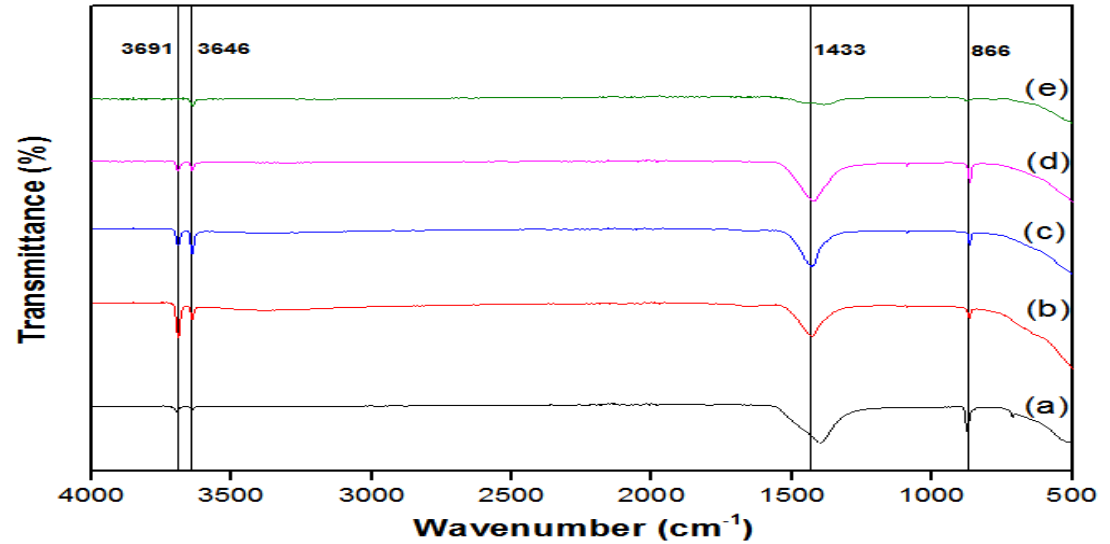
Figure 9. FTIR spectra of ( a ) Dolomite ( b ) 5 wt% K/D ( c ) 10 wt% K/D ( d ) 15 wt% K/D ( e ) 20 wt% K/D.